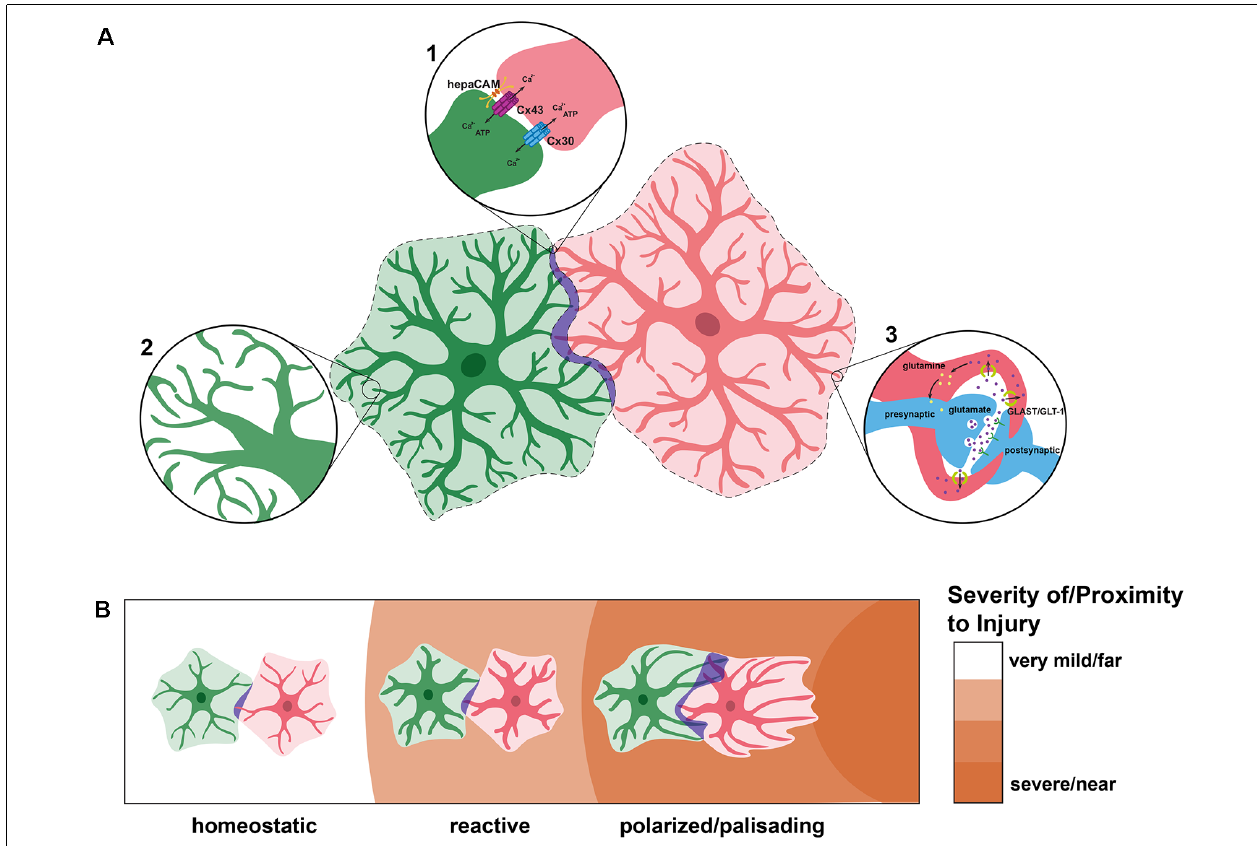
FIGURE 3 | Astrocyte tiling under physiological and pathological conditions. (A) Under physiological conditions, individual astrocytes overlap very minimally (purple), creating defined domains (dashed lines). In these spaces of overlap, astrocytes connect with one another via connexins 30 (Cx30) and 43 (Cx43), the latter of which is localized through HepaCAM (inset 1). Within their domains, astrocytes become highly branched and elaborate, sometimes forming connections with their own processes (inset 2). This extensive branching is represented by the lighter overlay around each astrocyte. Astrocytes regulate synapses by wrapping around them and insulating them, taking up excess neurotransmitters such as glutamate, and recycling them (inset 3). Each astrocyte is able to connect with thousands of synapses, a feature which has increased interest in astrocyte domains and networks. (B) After injury or insult, astrocytes can become reactive and undergo morphological changes including thicker processes but do not generally send processes outside of their domains. With nearby or severe insult, reactive astrocytes generate polarized astrocytes which can become palisading. These astrocytes may extend processes towards the injury which can protrude into the domains of neighboring